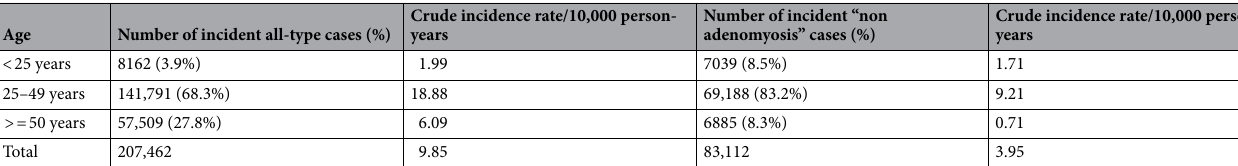
Age Number of incident all-type cases (%)